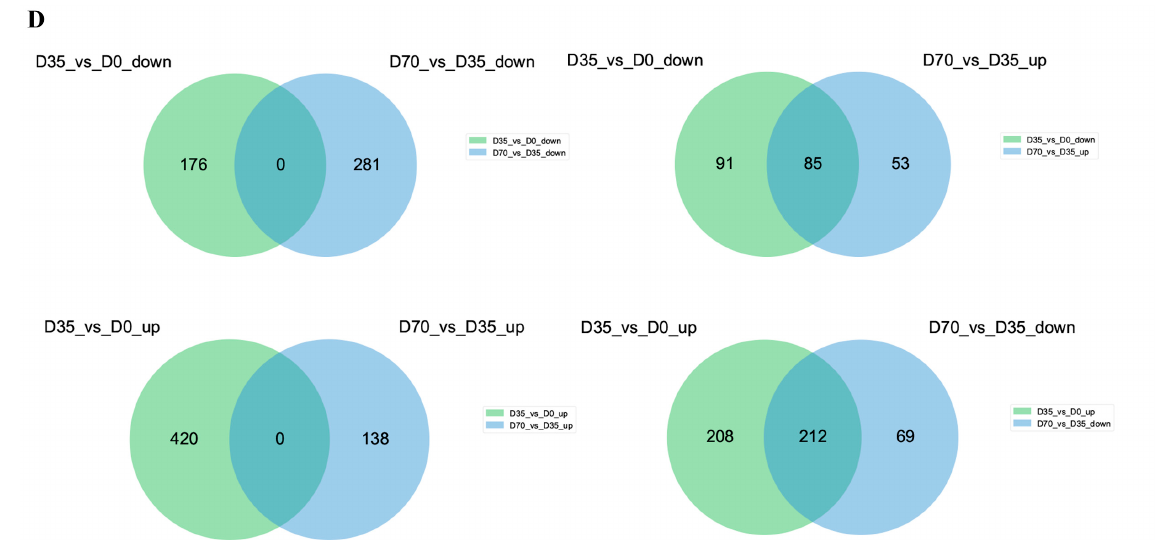
Figure 4. Differential analysis of circRNAs during skeletal muscle development of rabbits. ( A ) Hi- erarchical clustering analysis of nine samples with all identified circRNAs based on the CPM values. ( B ) Volcano plot of DECs in D35 vs. D0. ( C ). Volcano plot of DECs in D70 vs. D35 ( D ) Venn diagram showing the DECs at the two growth periods.